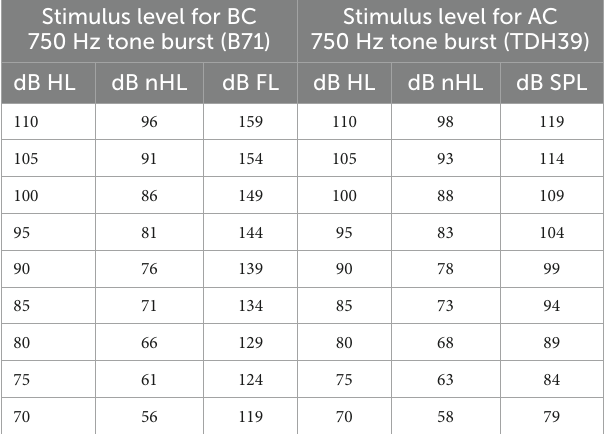
TABLE 1 Stimulus level conversion